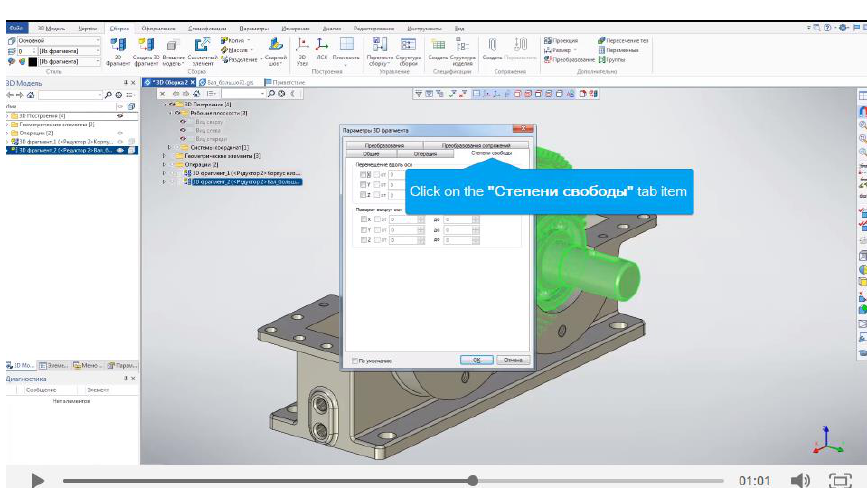
Fig. 14 . Video clip with the implementation of the shaft rotation in the